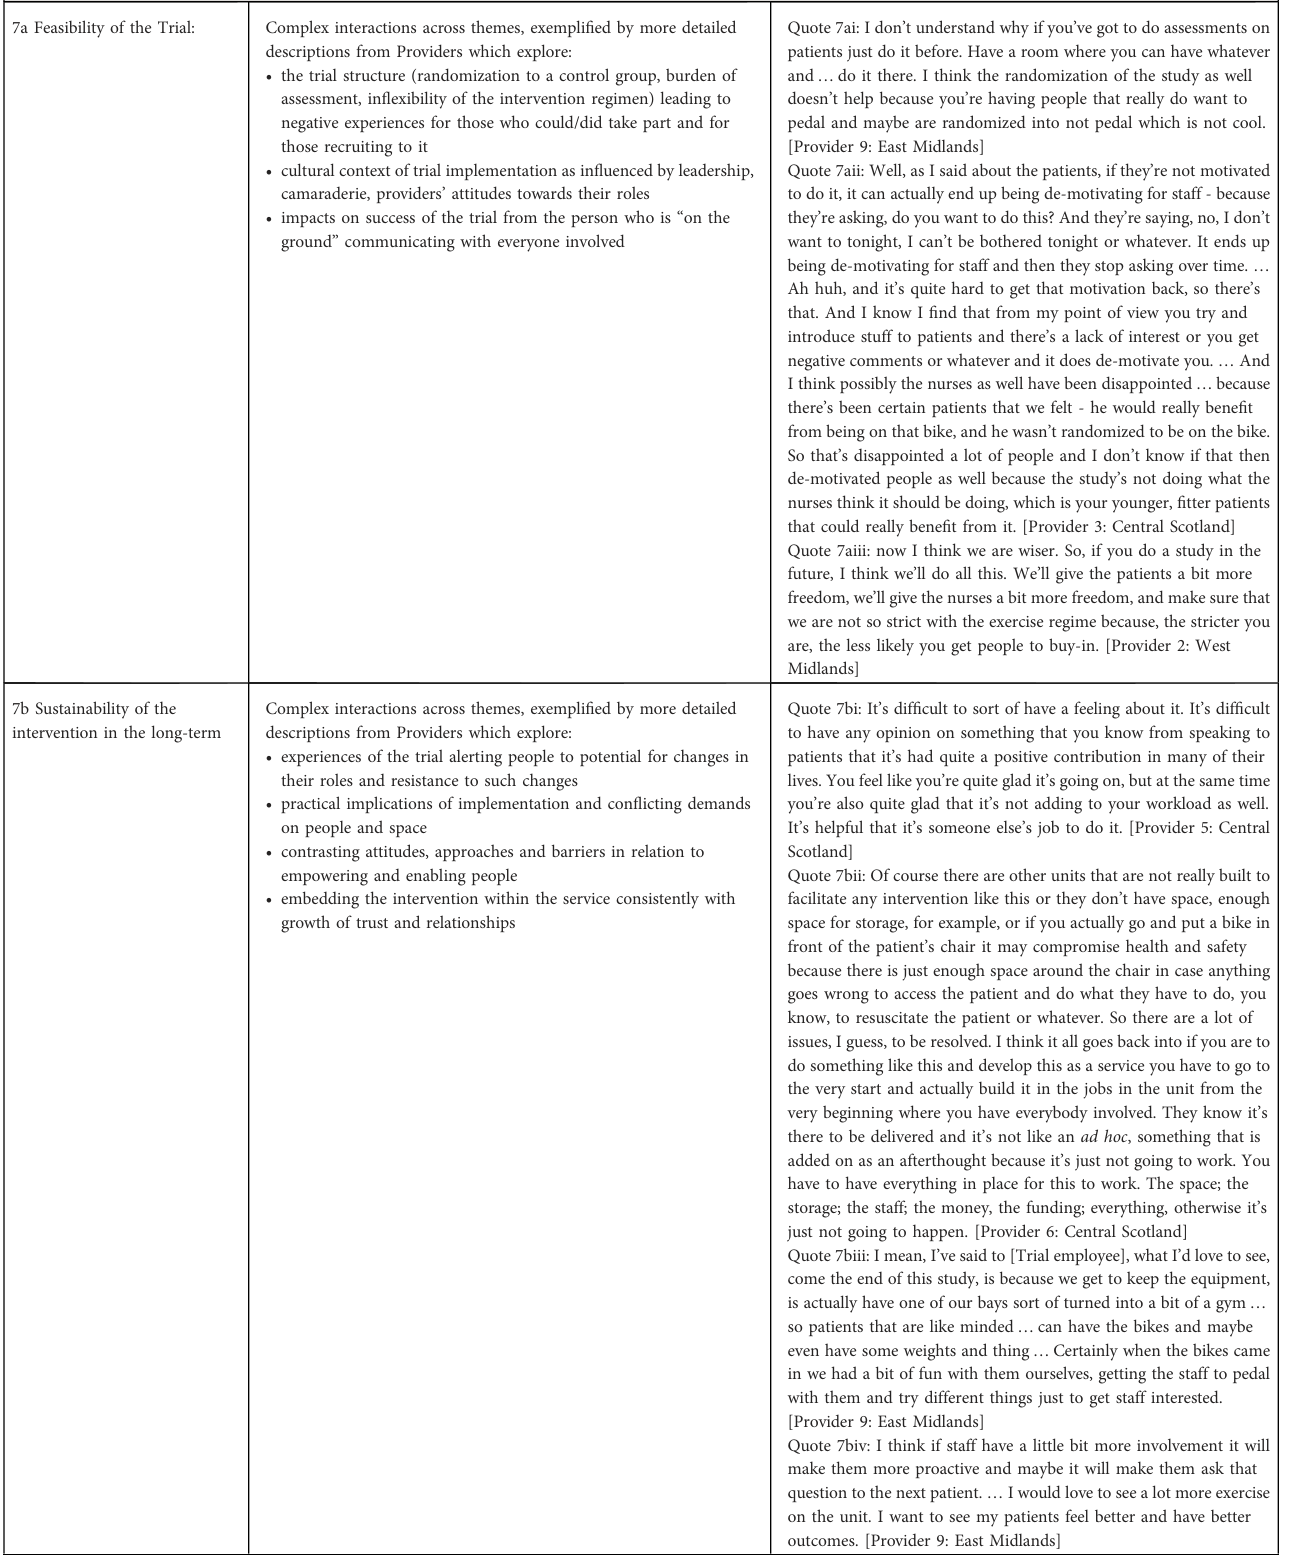
OVERARCHING THEME 7: Trial Feasibility and Intervention